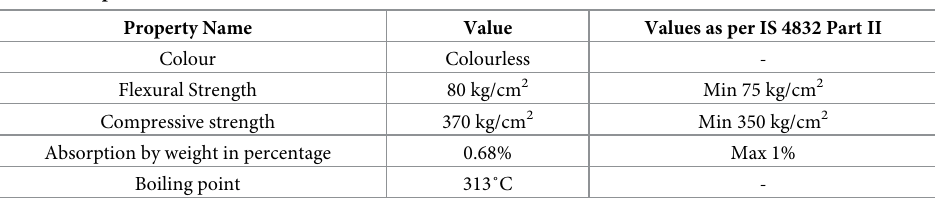
Table 5. Properties of furan resin.